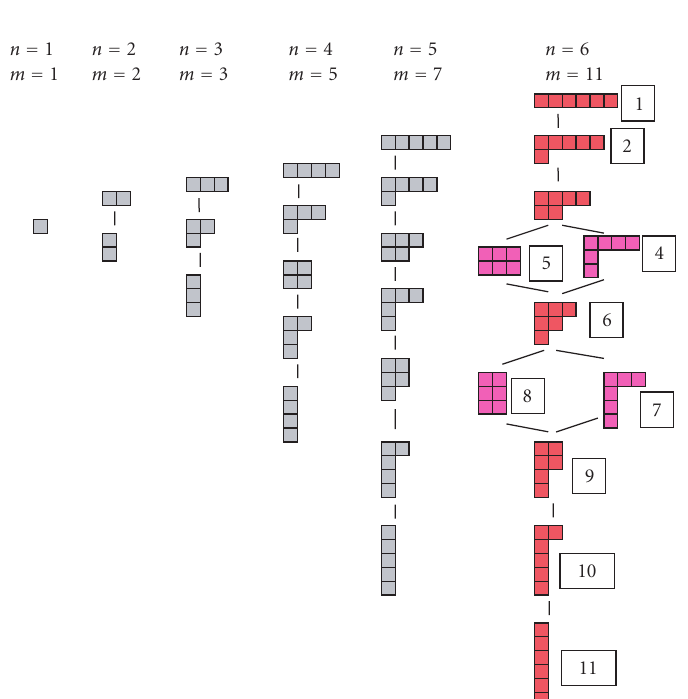
Figure 4.5. Diagram lattices of n boxes and m diagrams within each lattice. The totally ordered sets are given in grey coloured boxes, whereas the partially ordered set for n = 6 is represented with red and pink coloured boxes. The pink coloured diagrams of the same level are incomparable elements of this lattice. The numbers p with 1 ≤ p ≤ m at the right side of the diagrams demonstrate their sequence with respect to the total order given by Young, which is identical with the order of the sums n = 6. S ( O γ ) of the partial sums (4.4) [26] in case of the lattice for